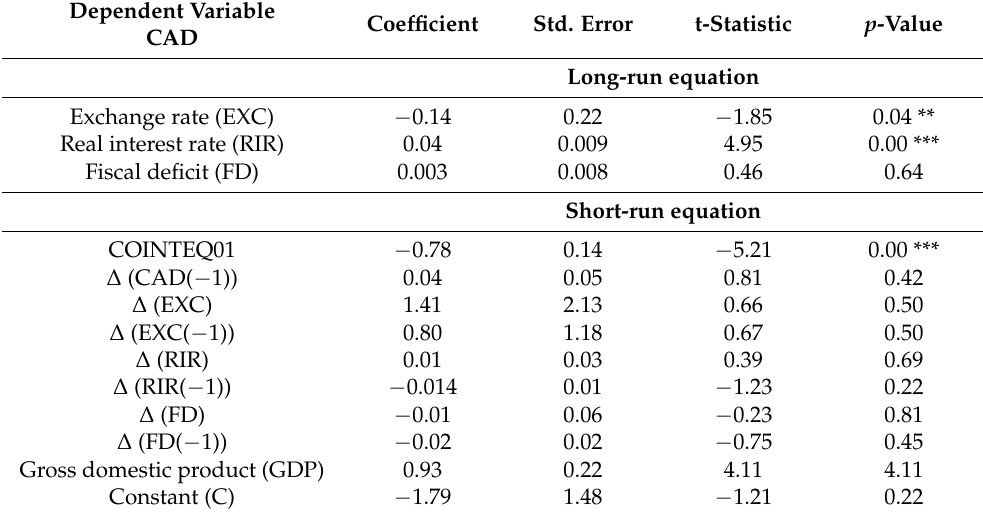
Table 10. Findings of panel auto-regressive distributed lag (ARDL) for lower-middle-income economies